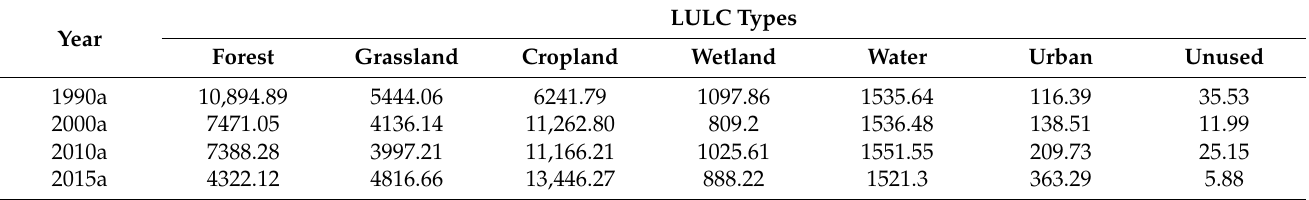
Table A1. Areas of various LULC types in Rwanda from 1990 to 2015 (km 2 ).